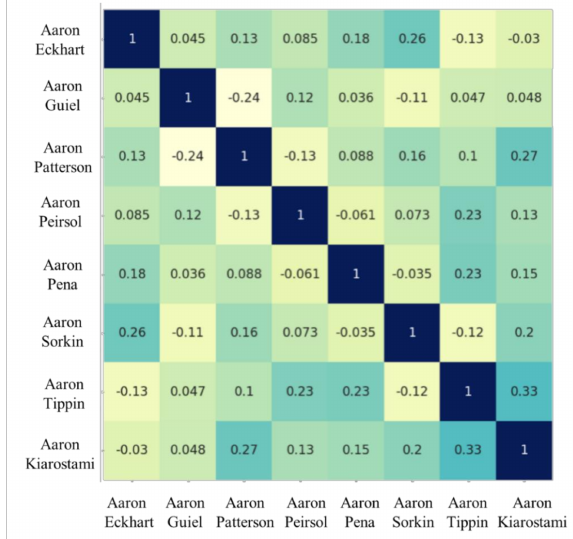
Figure 12. The matrix of similarity examples for the LFW test set with FN13-generated face embedding corresponding to each sample